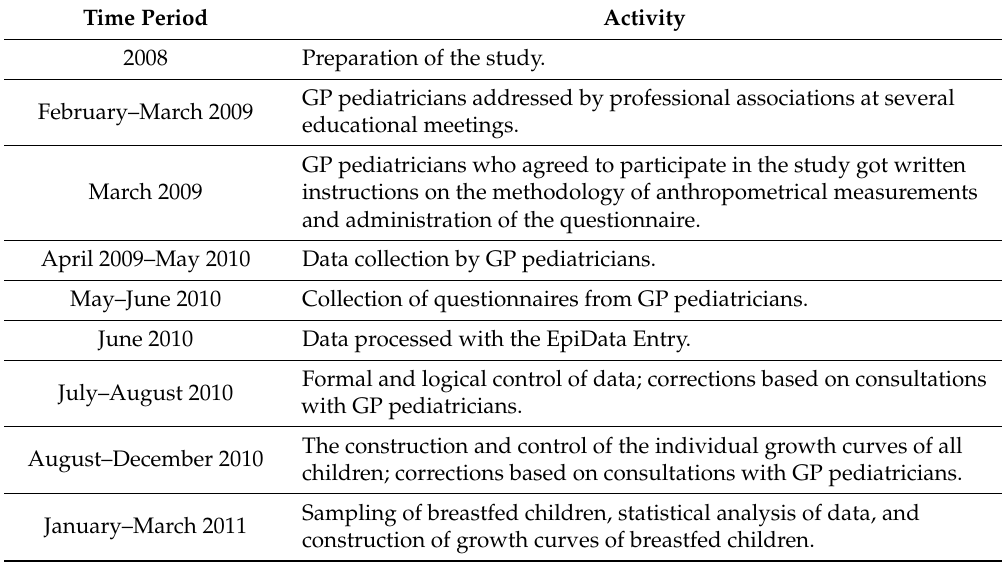
Table 1. Time schedule of the